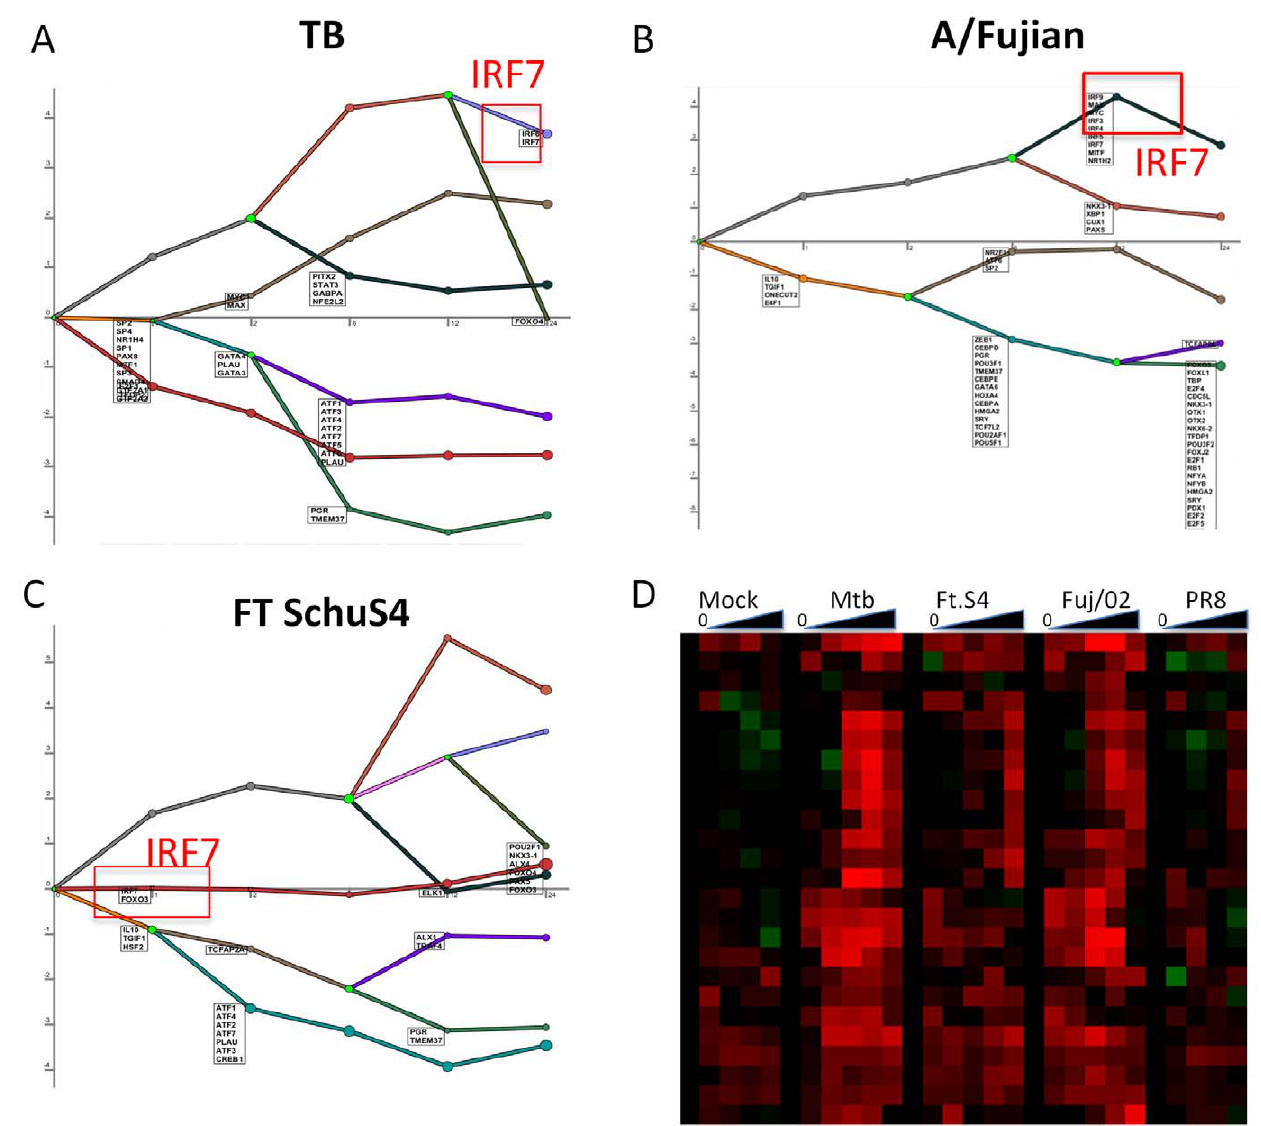
Figure 6. Analysis of transcription factors reveals a changing pattern for IRF7 following infection of murine AM. (A, B and C). Analysis of the transcription factors responsible for different pattern of gene expression using the program DREM revealed divergent roles for IRF7 in Mtb (A) Fuj/02 (B) and Schu S4 (C) infection of murine AM. The program identifies transcription factors responsible for bifurcations and gene trajectories and these are listed at the appropriate in order of significance. The position of IRF7 is highlighted with the red square. Lines represent the average expression patterns of DE genes for each of the infections shown. D. Heatmap of genes known to be controlled by IRF7 that were included in the DREM analysis, confirming the divergent expression patterns of these genes in the three